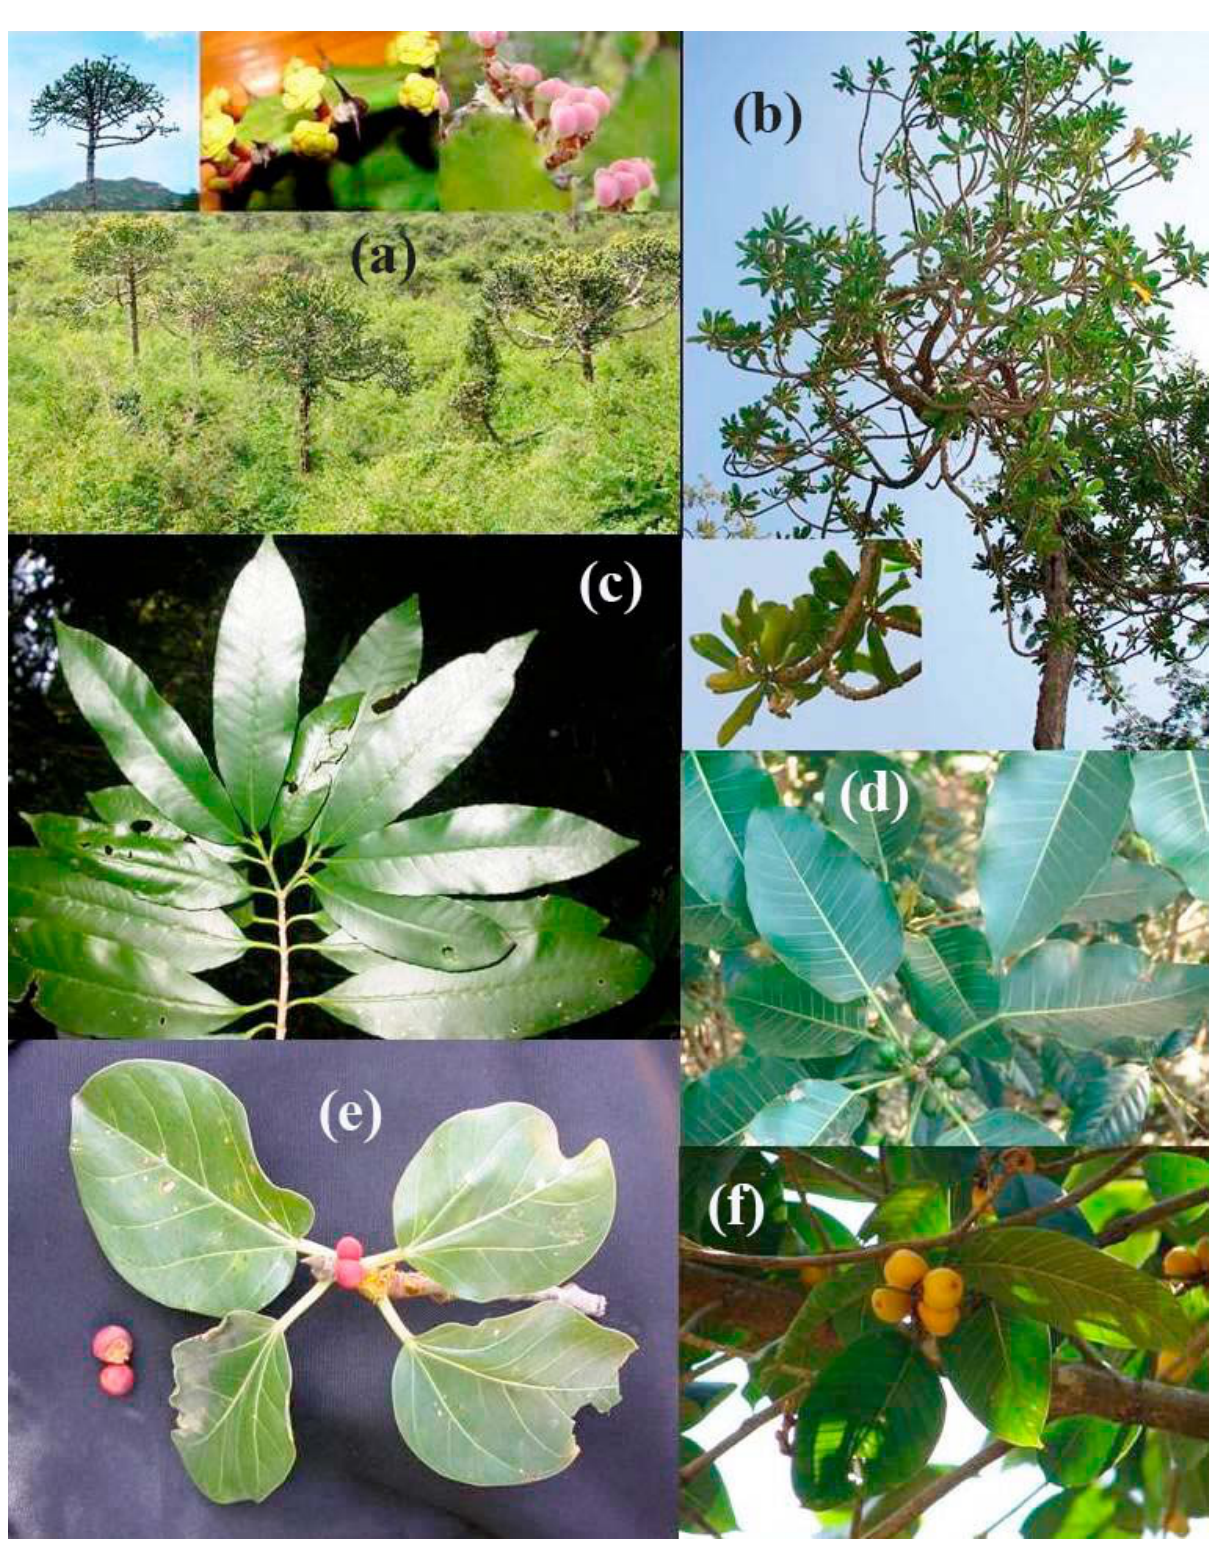
Figure 10. a) Euphorbia antiquorum (Euphorbiaceae); b) Euphorbia nivulia (Euphorbiaceae); c) Excoecaria robusta (Euphorbiaceae); d) Ficus beddomei (Moraceae); e) Ficus benghalensis (Moraceae); f) Ficus drupacea var. pubescens (Moraceae). Photo by L. Arul